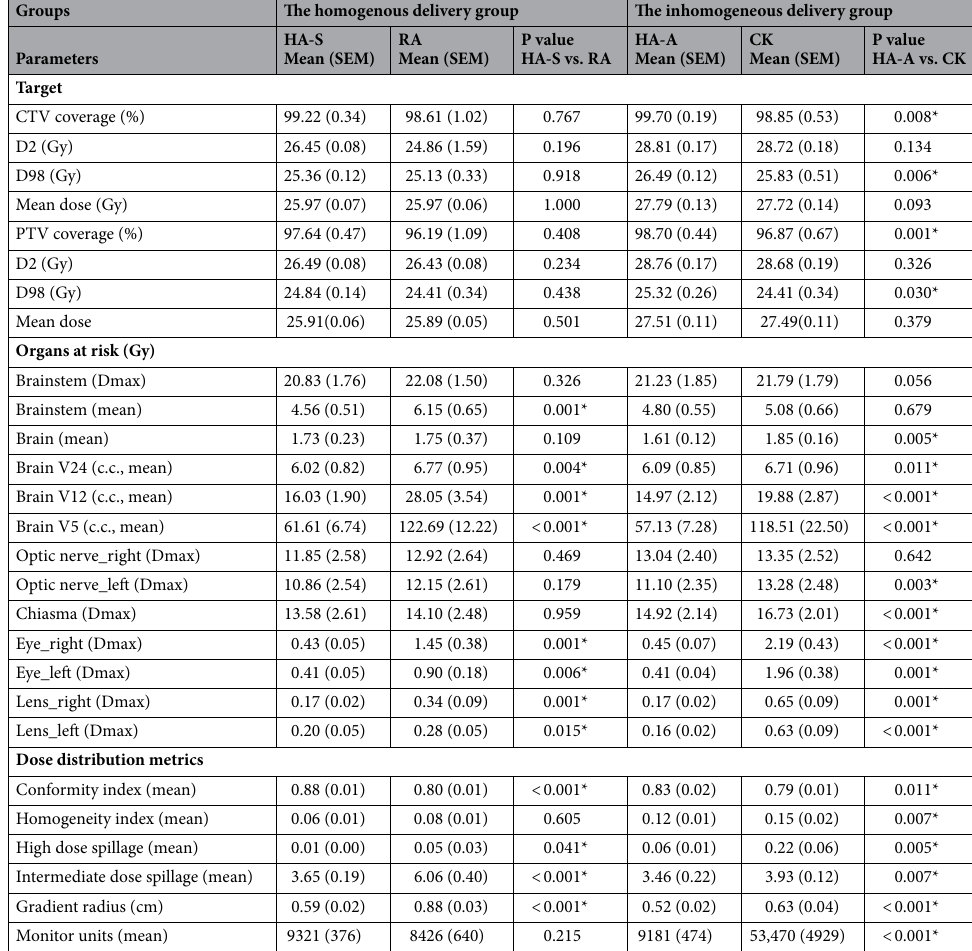
Table 3. Comparison of dosimetric parameters for HyperArc, RapidArc, virtual CyberKnife and CyberKnife for the benign brain lesions. CTV clinical tumor volume, the volume of the benign brain lesion, PTV